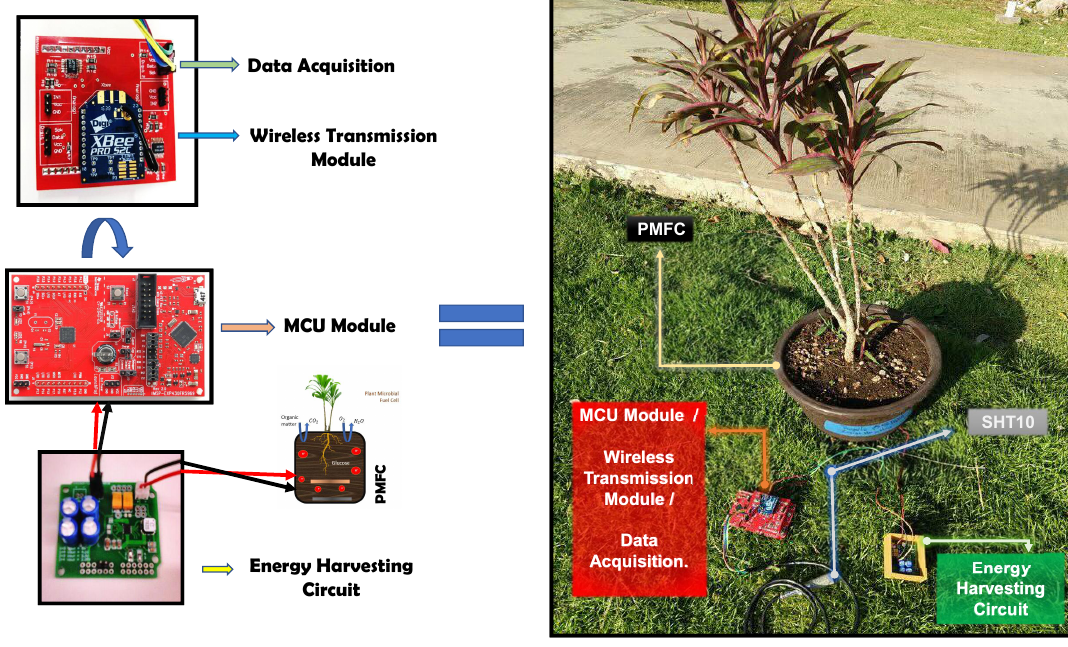
Figure 4. PMFC-EH Sensor